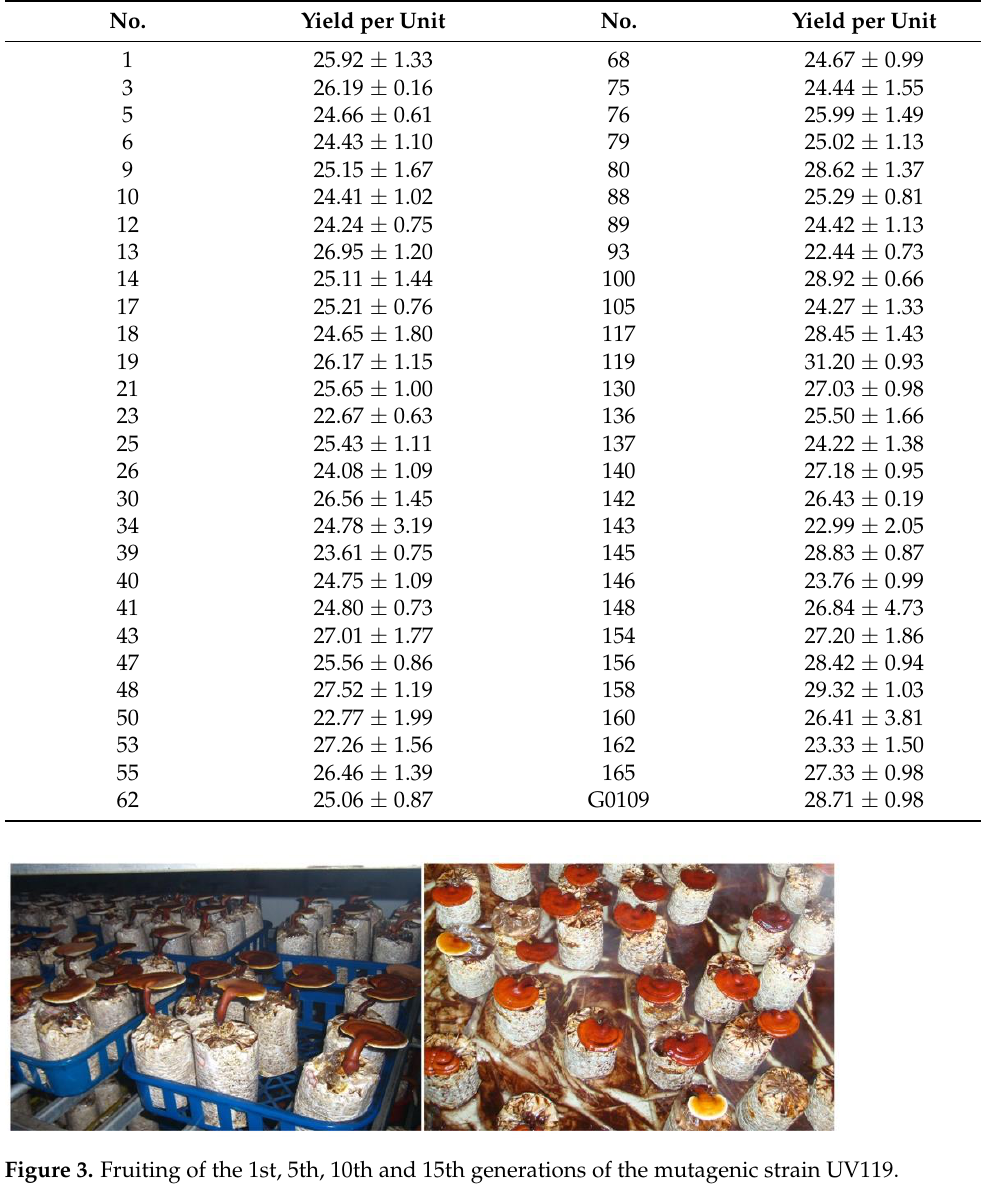
Table 3. The unit output (gram per spawn) of mutagenic strains.